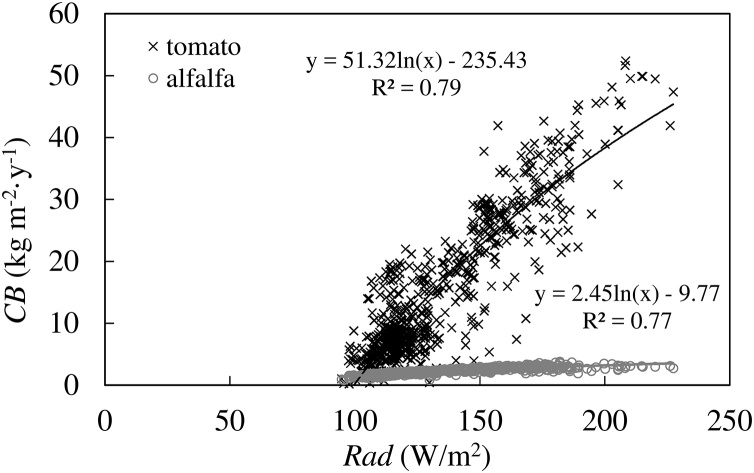
Bulk biomass of tomato and alfalfa versus radiation.